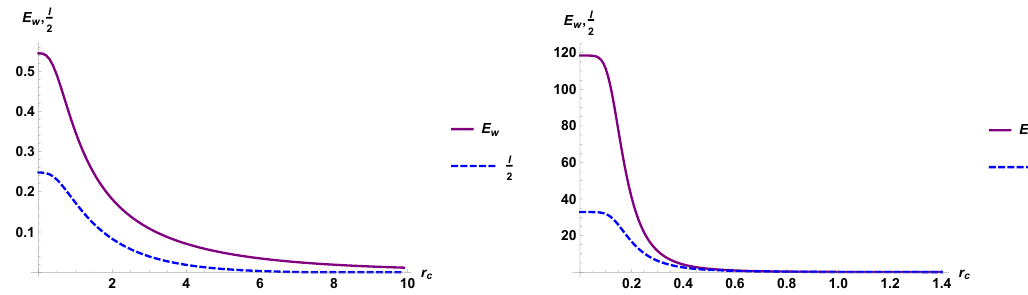
Figure 20 . E W as a function of r c for: Left ) ‘ = 5 , h = 1 and d e = 2 . Right ) ‘ = 1 , h = 0 . 1 and d e = 5 . The dashed blue curves are half of the HMI and the solid purple curves are E W . Here we divided both E and I by R d L d − 1 W 2 G N r θ F